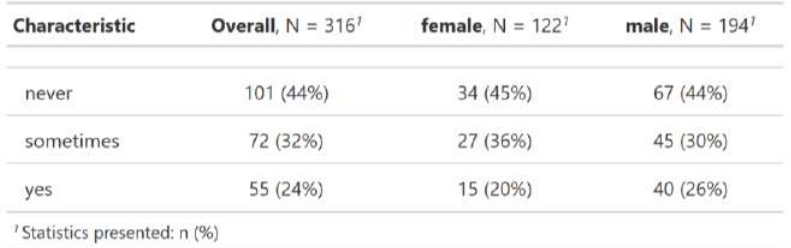
Table 7: When you visit India, is your experience according to your expectations? (Source: Authors‟ depiction )